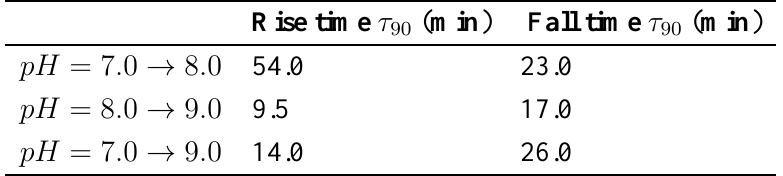
Table 1. Rise and fall times estimated during the three performed